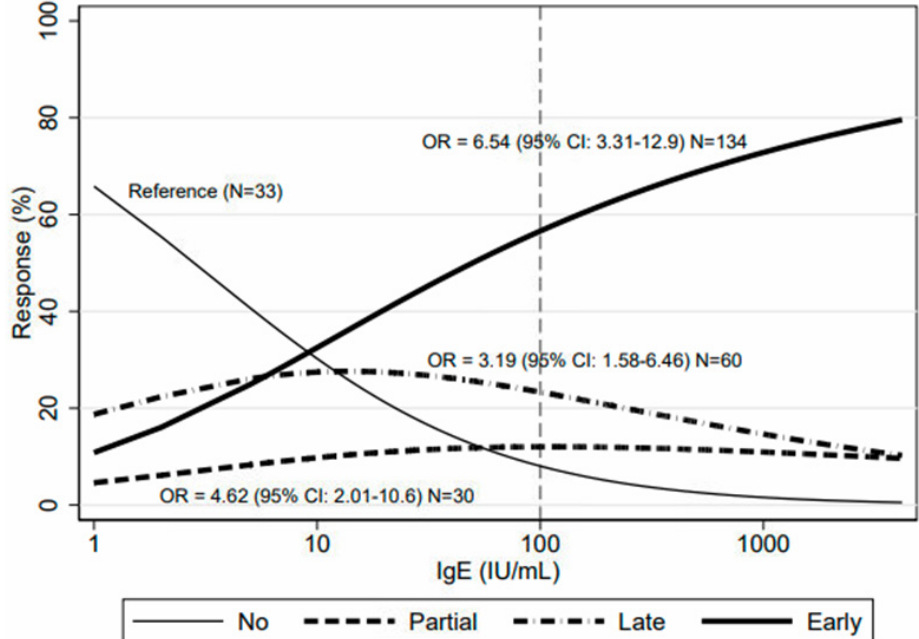
Figure 3. Predicted probability (%) of no, partial, late or early response to omalizumab according to IgE levels (continuous) from a multinomial logistic regression.